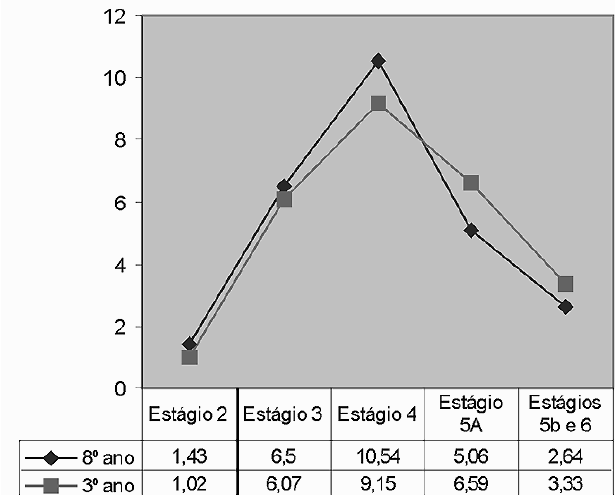
Figura 3. Pontua(cid:231)ªo mØdia bruta dos jovens brasileiros de 8” ano e 3” ano no DIT-1.